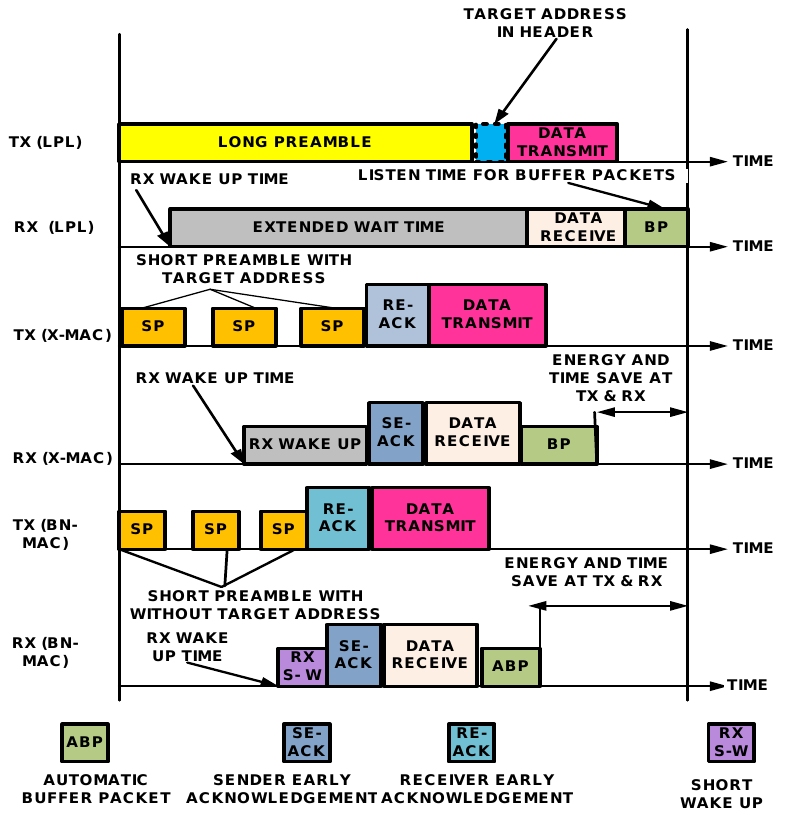
Figure 6. Comparison of the timelines of duty-cycle MAC